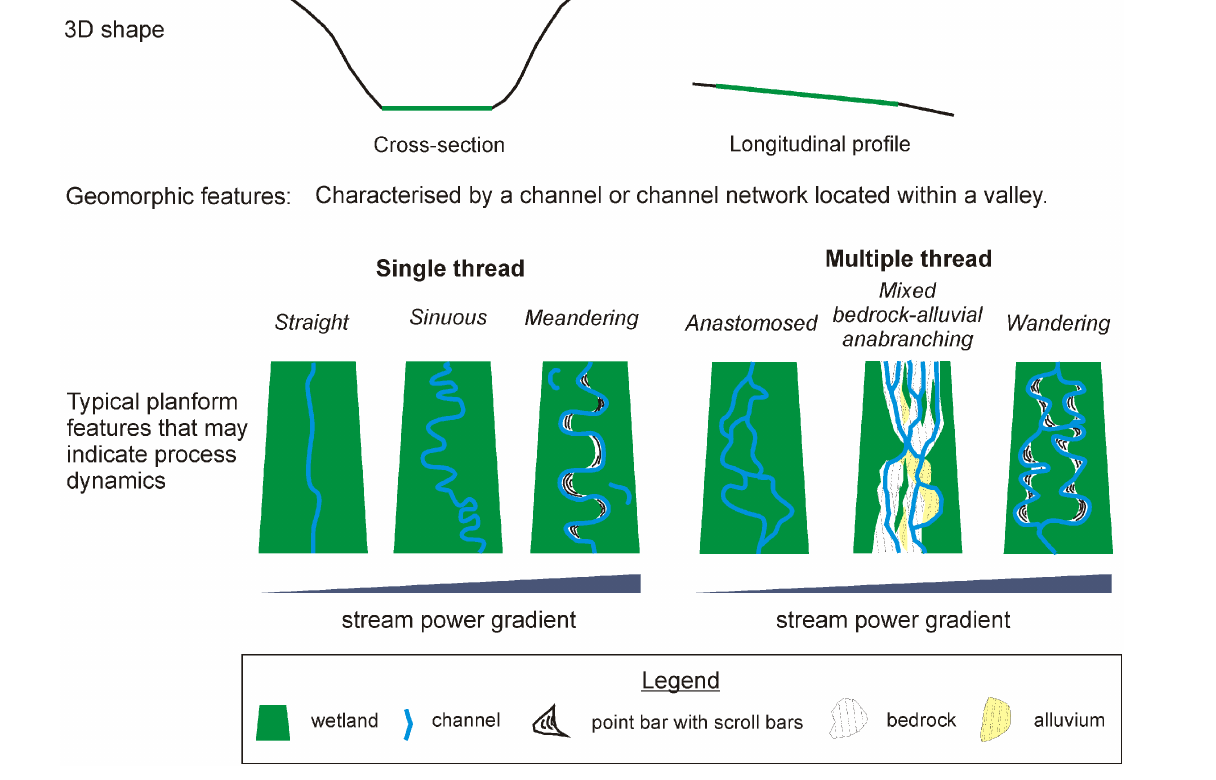
Frontiers in Environmental Science |